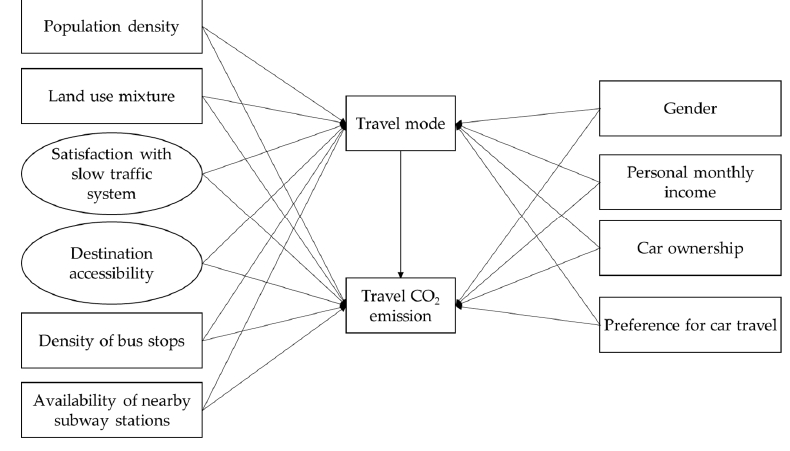
Figure 7. SEM path diagram.